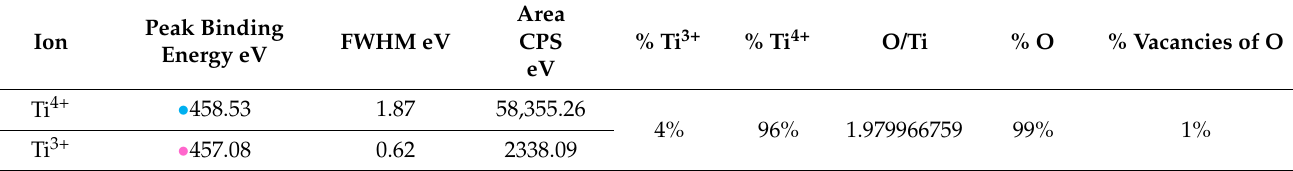
Table 4. Data from XPS measurements on the pure titania used in this work and calculations to determine the precentage of oxygen vacancies in the crystal